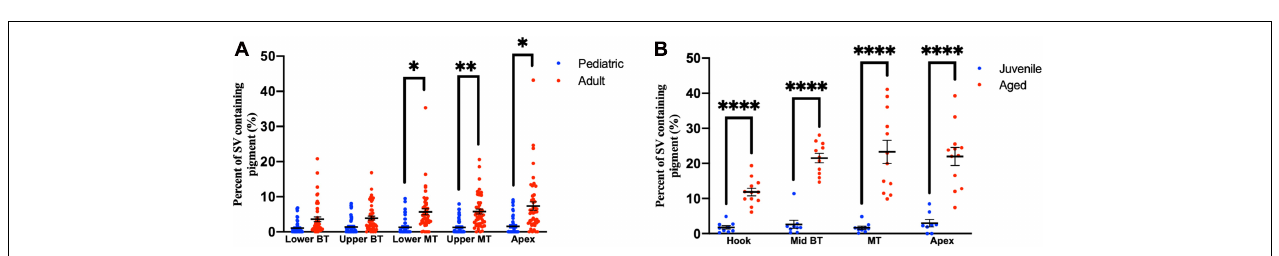
FIGURE 3 | Percentage of the stria vascularis containing pigment within human (A) and mouse (B) temporal bones. Error bars indicate standard error. Stria vascularis, SV; BT, basal turn; MT, middle turn. ∗ Adjusted p -value < 0.05, ∗∗ adjusted p -value < 0.01, and ∗∗∗∗ adjusted p -value < 0.0001.